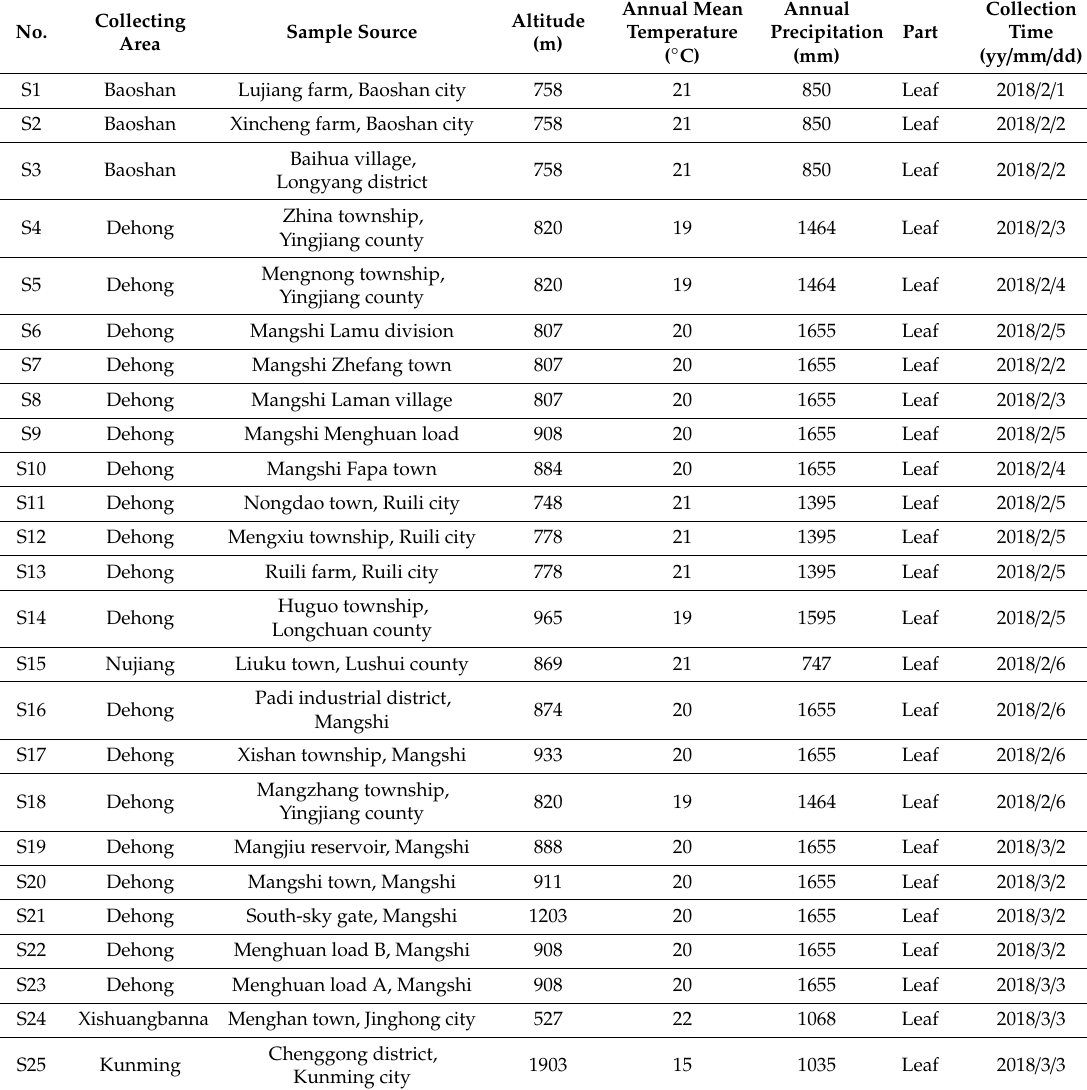
Table 4. Representative samples of Moringa oleifera investigated in this